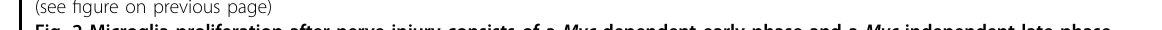
found that the microglia in naive Tnfaip3 cKO mice had a substantial proportion of S-phase and G2/M-phase cells (Fig. 3e), consistent with our fl ow cytometry and IHC results of enhanced microglia proliferation in naive Tnfaip3 cKO mice. Interestingly, the distribution of the S- and G2/M-phase cells in PCA plot of naive Cx3cr1-creER- yfp/ + ; Tnfaip3 fl / fl cKO mice without injury (Fig. 3e) was similar to that of Cx3cr1-creER-yfp/ + ; + / + control mice 3 days after nerve injury (Fig. 1d), but was quite different from that of Cx3cr1-creER-yfp/ + ; + / + animals 2 days after nerve injury (Fig. 1c).